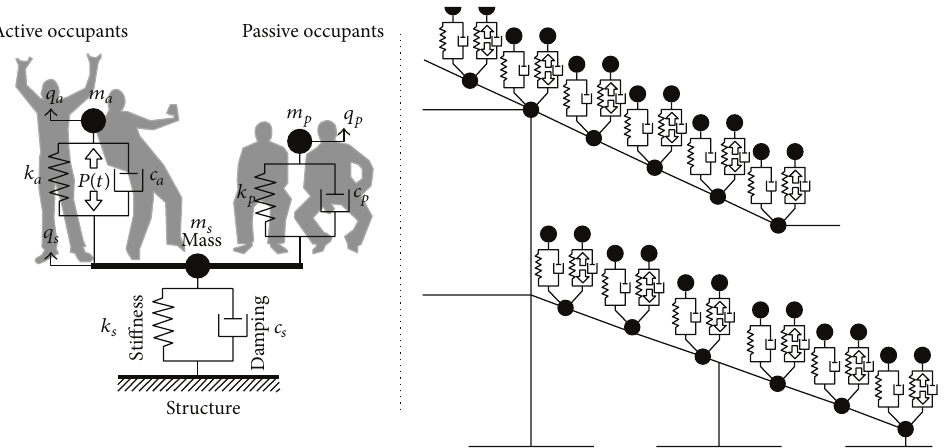
Figure 16: The crowd model used by UK recommendations for design of permanent grandstands